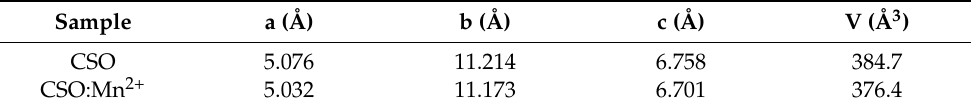
Table 1. The calculated lattice parameters of pure and 2% Mn 2+ -doped Ca 2 SiO 4 samples.